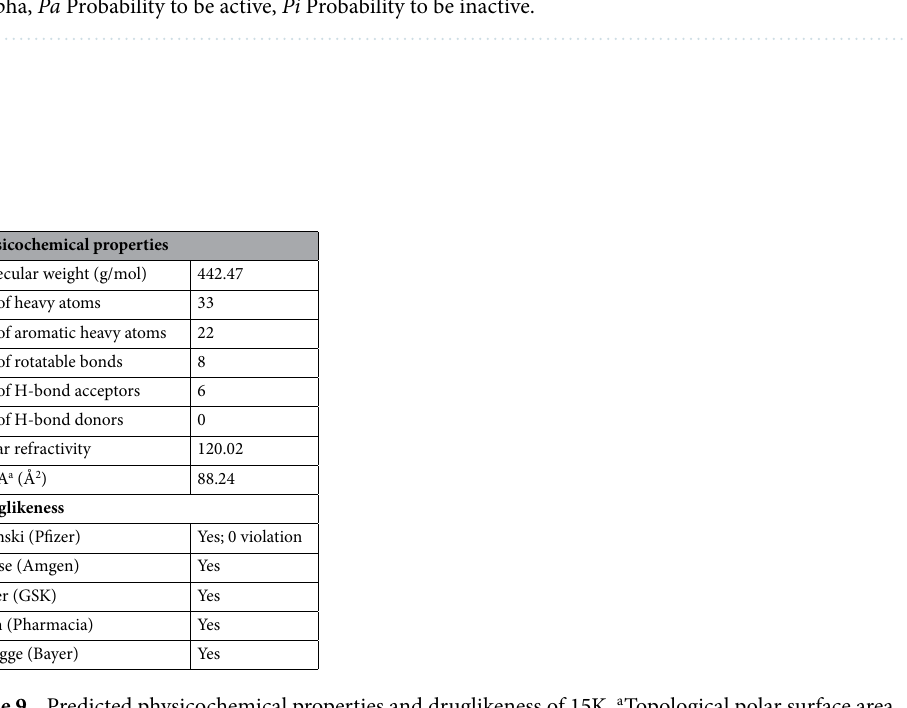
Table 9. Predicted physicochemical properties and druglikeness of 15K. a Topological polar surface